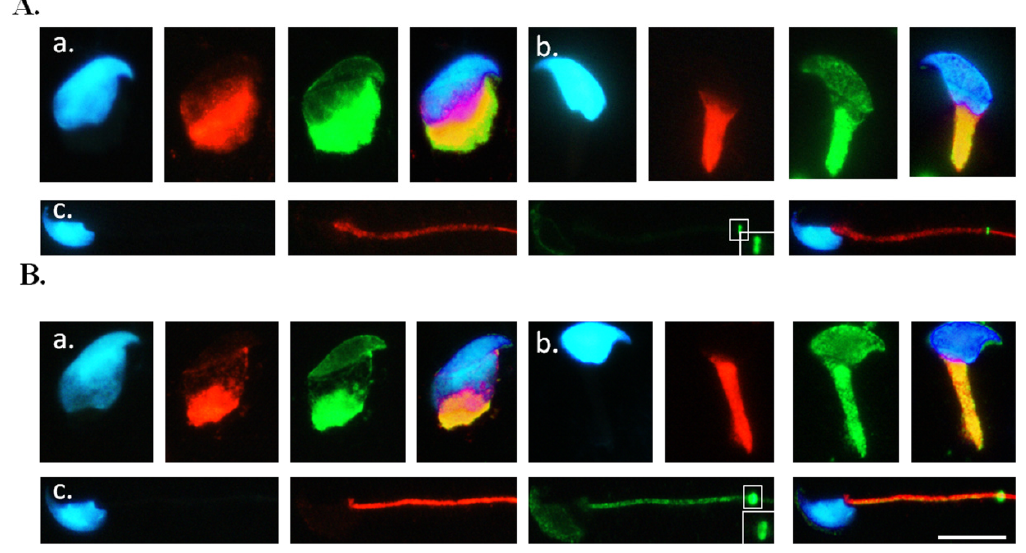
Figure 3. SEPT12 is co-localized with α - and β -tubulin at different steps of spermiogenesis in the SEPTIN12 -transgenic mice. Immuno-fluorescence detection of SEPT12 and α -tubulin ( A ) or β -tubulin ( B ). Anti-EGFP antibody ( A and B ; Green), anti- α -tubulin ( A , Red), anti- β -tubulin ( B , Red) and DAPI ( A and B ; Blue). ( a ) early elongation stage; ( b ) elongating; ( c ) mature sperm. From left to right: DAPI (Blue), tubulin (Red), SEPT12 (Green) and merge of pictures. Enlarge figures are shown in right lower corner of ( c ). Scale bar : 5 μ